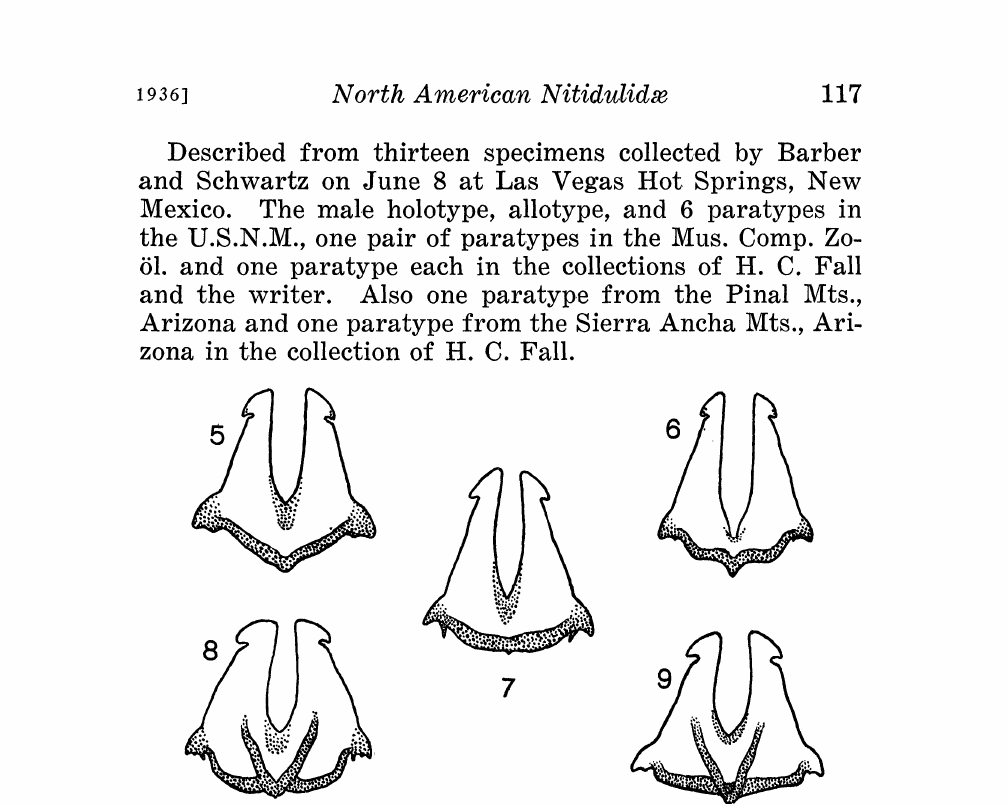
Fig. 2. Ventr.al views of the coxites o.f th,e female genitalia in Po.cadius. 5, P. basalis Schaeff, ev (’topotype); 6, P. helol.us Er.; 7, P. niger n. sp. (paratype); 8, P. fe’rrugineus L.; 9, P. fulvipennis